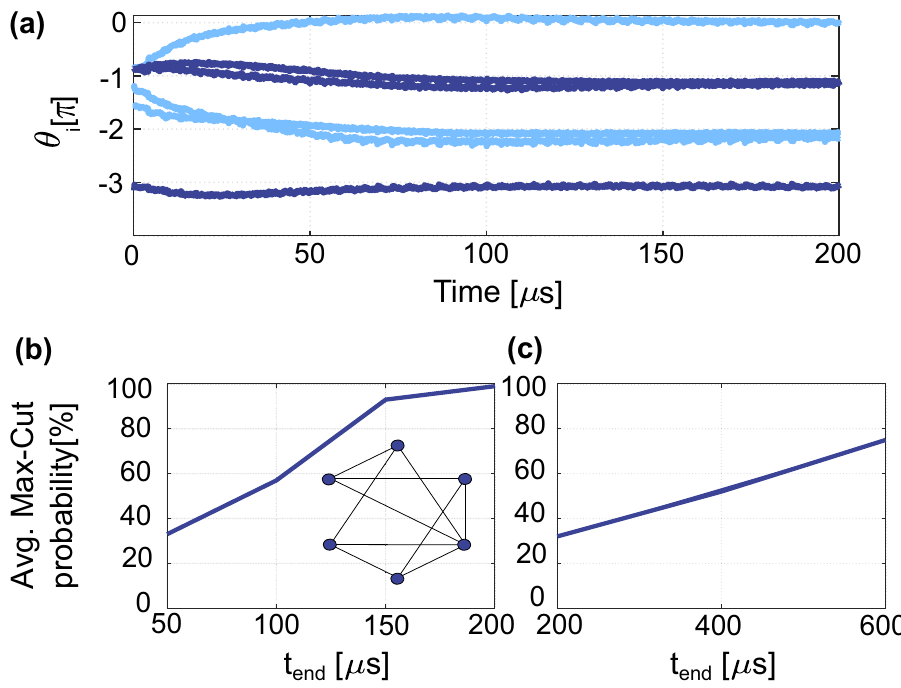
Figure 6. ( a ) Phase dynamics of a network of six all-to-all coupled ring oscillators solving the Max-Cut problem in Fig. 3a, ( b ) average Max-Cut probability for ten randomly generated graphs of size 6 (10 runs of each graph) for different simulation times t end and ( c ) average Max-Cut probability of randomly generated graphs mapped to 3 hexagonal cells (implemented with 13-stage RC ring